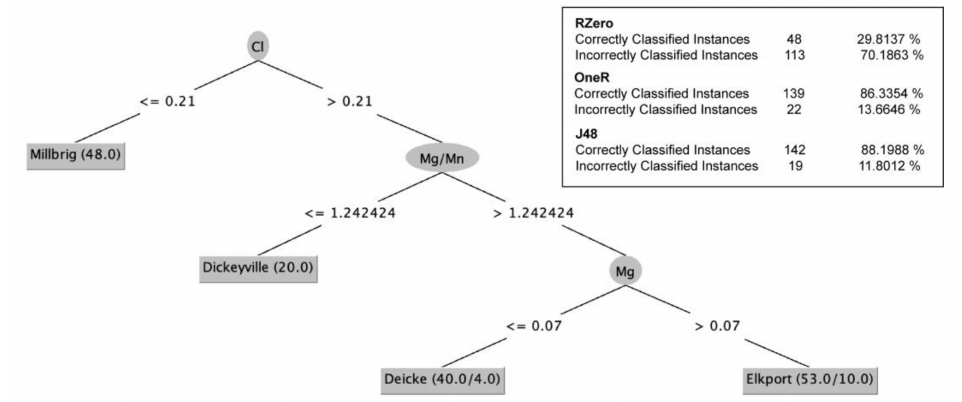
Figure 3. UMV-model decision tree of four prominent Ordovician K-bentonites using the J48 classifier. Shown in the inset are the percentages for correctly and incorrectly classified instances based on different decision modes. RZero: essentially guessing the most abundant class for every instance; OneR: classifying each instance based on only one variable.